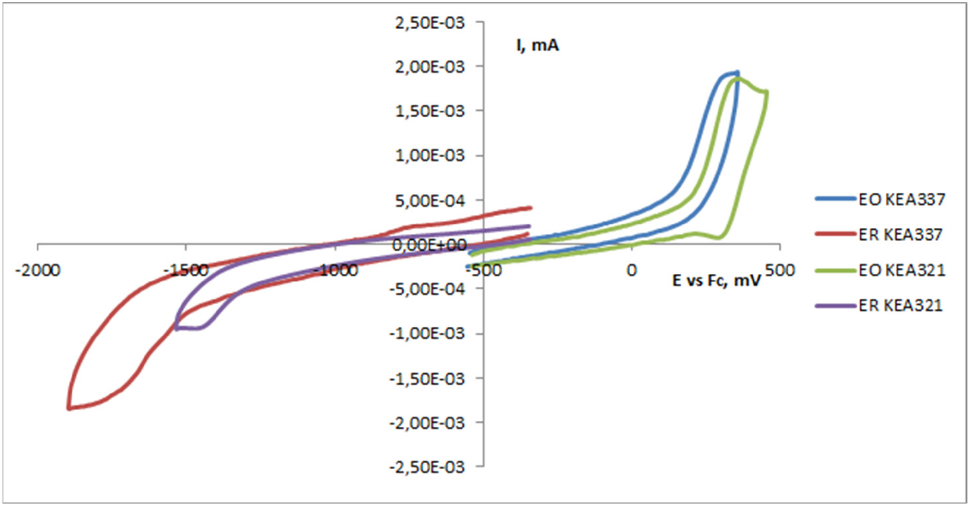
Figure 4. Absorption spectra of КЕА dyes in DCM solutions (5.5 × 10 − 5 M).